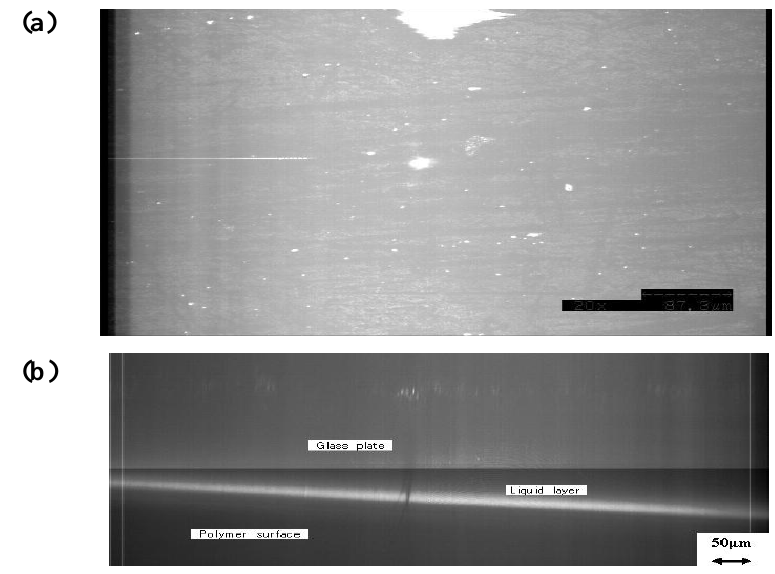
Figure 11. (a) CLSM image of PVA-H surface under the loading (×700). Third area